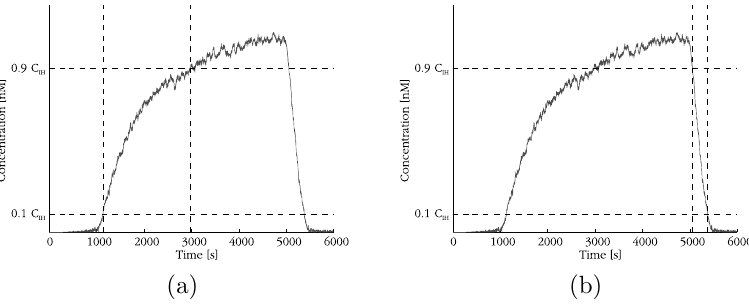
Figure 6. Evaluating the switching times on an example of signal presenting time evolution of protein dimer concentrations. Figure (a) presents the evaluation of rise time and Figure (b) the evaluation of fall